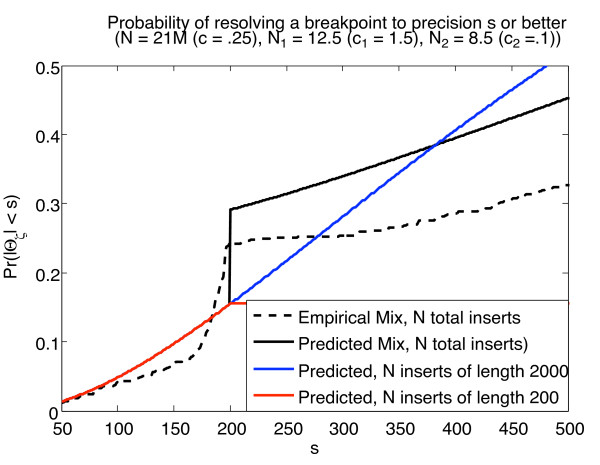
Combination of insert lengths for breakpoint detection. Figure 3: The solid lines indicated the theoretically predicted probabilities as described in METHODS. The dotted line indicates an empirical mix, using 4 lanes each from 200 and 2000 base pair insert runs. N (c) correspond to the combined number of reads (sequence coverage) uniquely mapped at both ends.